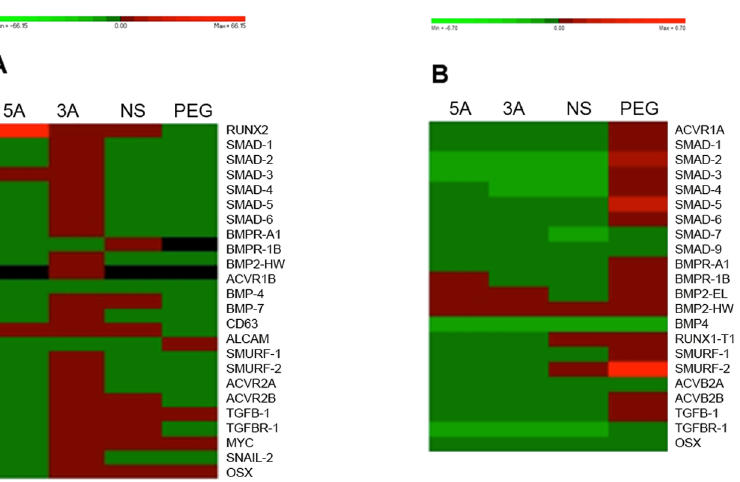
Fig 5. Fluidigm analysis. Heat-Map of (A) MG63s and (B) MSCS treated with the GNPs for 48 hours (green reflects a decrease in expression, whilst red reflects an increase). The data was analysed using PermutMatrix and ordered into hierarchy based on expression